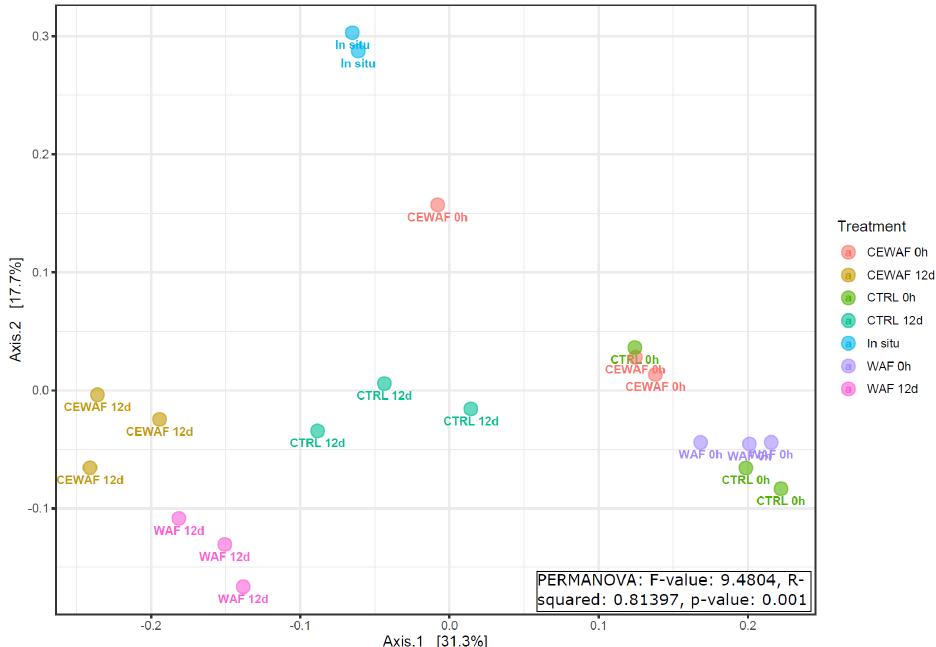
Microorganisms 2023 , 11 , x FOR PEER REVIEW 2 of 2 Figure 6. PCoA of microbial communities comparing high and low oil level Gulf of Finland experi- ments. PCoA was based on a Bray–Curtis distance matrix using genera data.